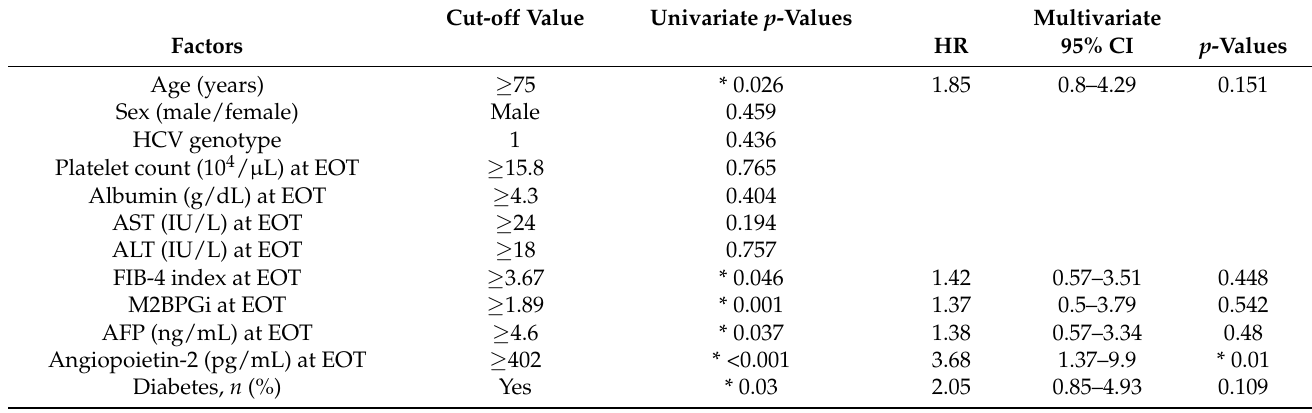
Table 3. Factors at the end of treatment associated with HCC occurrence after DAA therapy. Cut-off